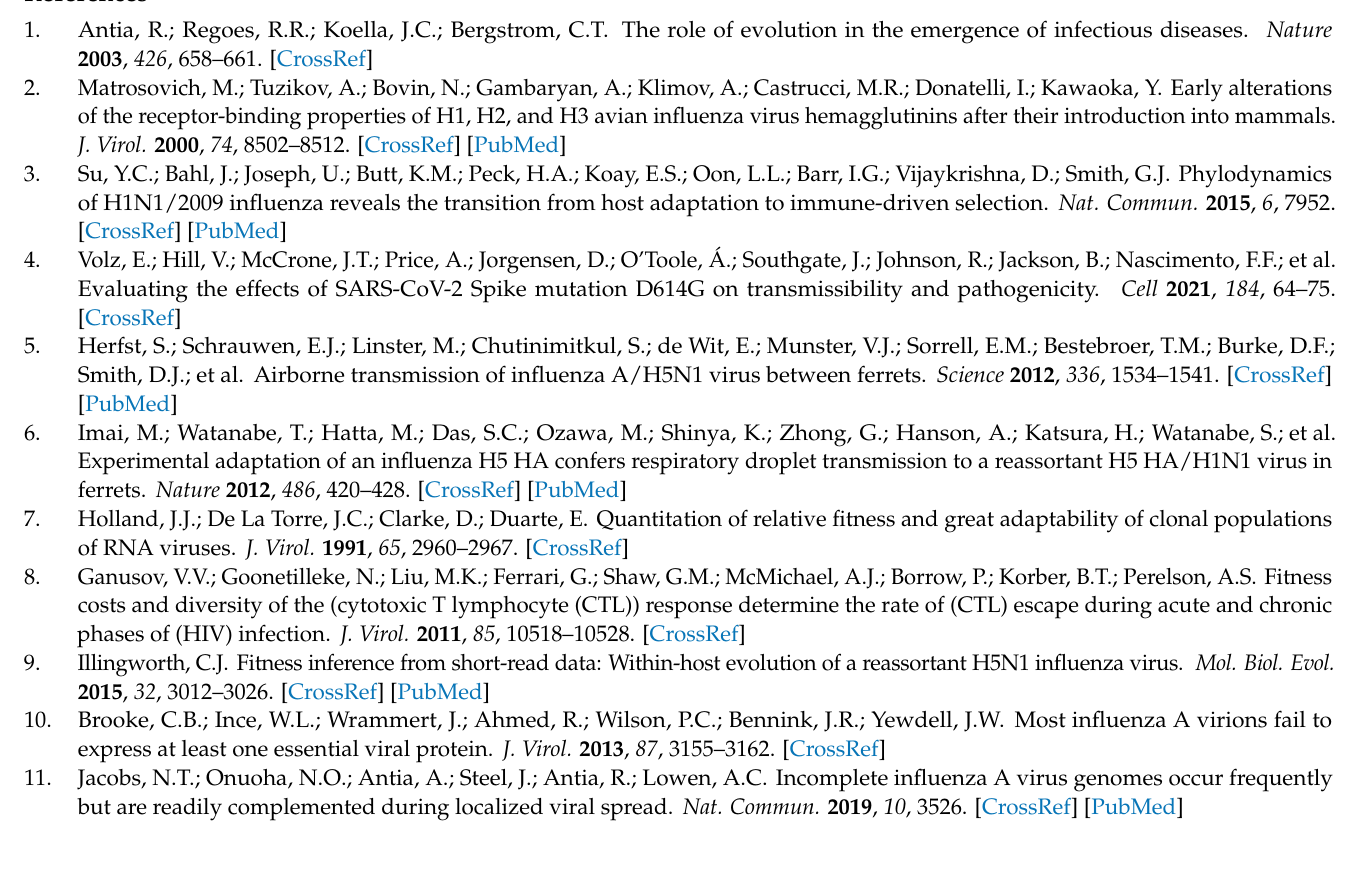
challenge study data. Figure S11: Posterior distributions of initial G788A frequencies from fitting the stochastic within-host model. Figure S12: Fitness estimation for variant G788A, assuming stochastic within-host dynamics, parameterized with an effective viral population size of N =